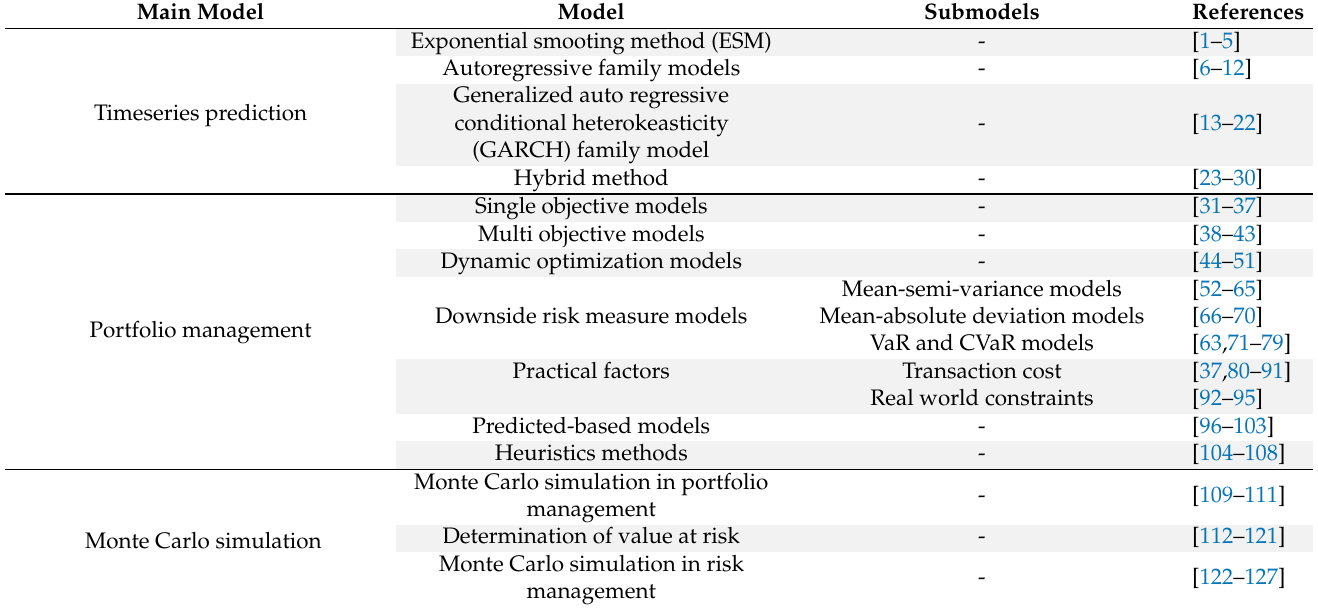
Table 1. A review of models, submodels, and references addressed in this